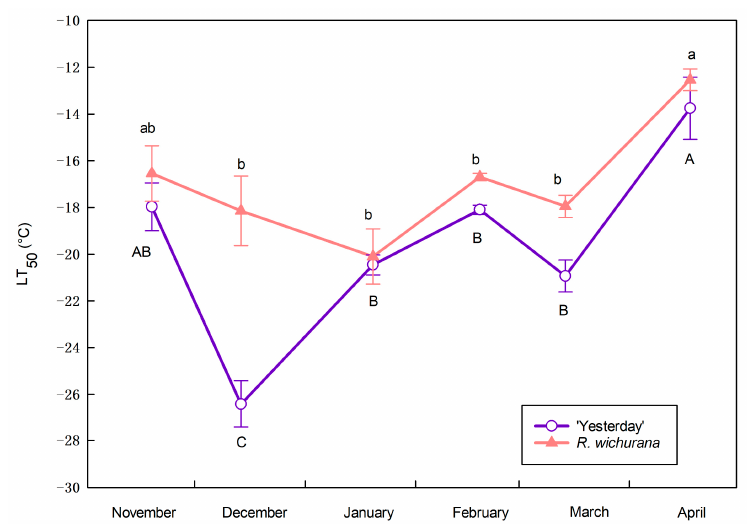
Figure 1. Seasonal changes of cold hardiness of stems expressed as LT 50 (temperature of 50% relative electrolyte leakage) of two rose genotypes ( Rosa hybrida ‘Yesterday’ and R. wichurana ). Different letters indicate significant differences among sampling time points within each genotype ( p = 0.05). Values are means ± SE ( n = 5).